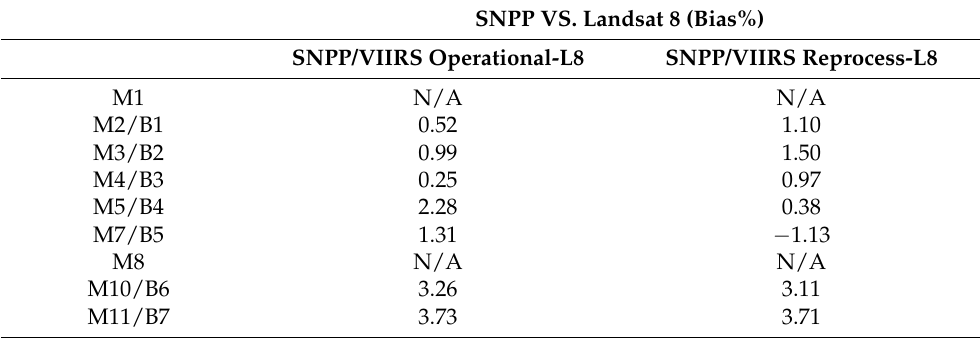
Table 4. The mean and standard deviation of the reflectance ratio percentage between Landsat 8/OLI with operational and reprocessed SNPP/VIIRS at RVUS from May 2013 to August 2019.